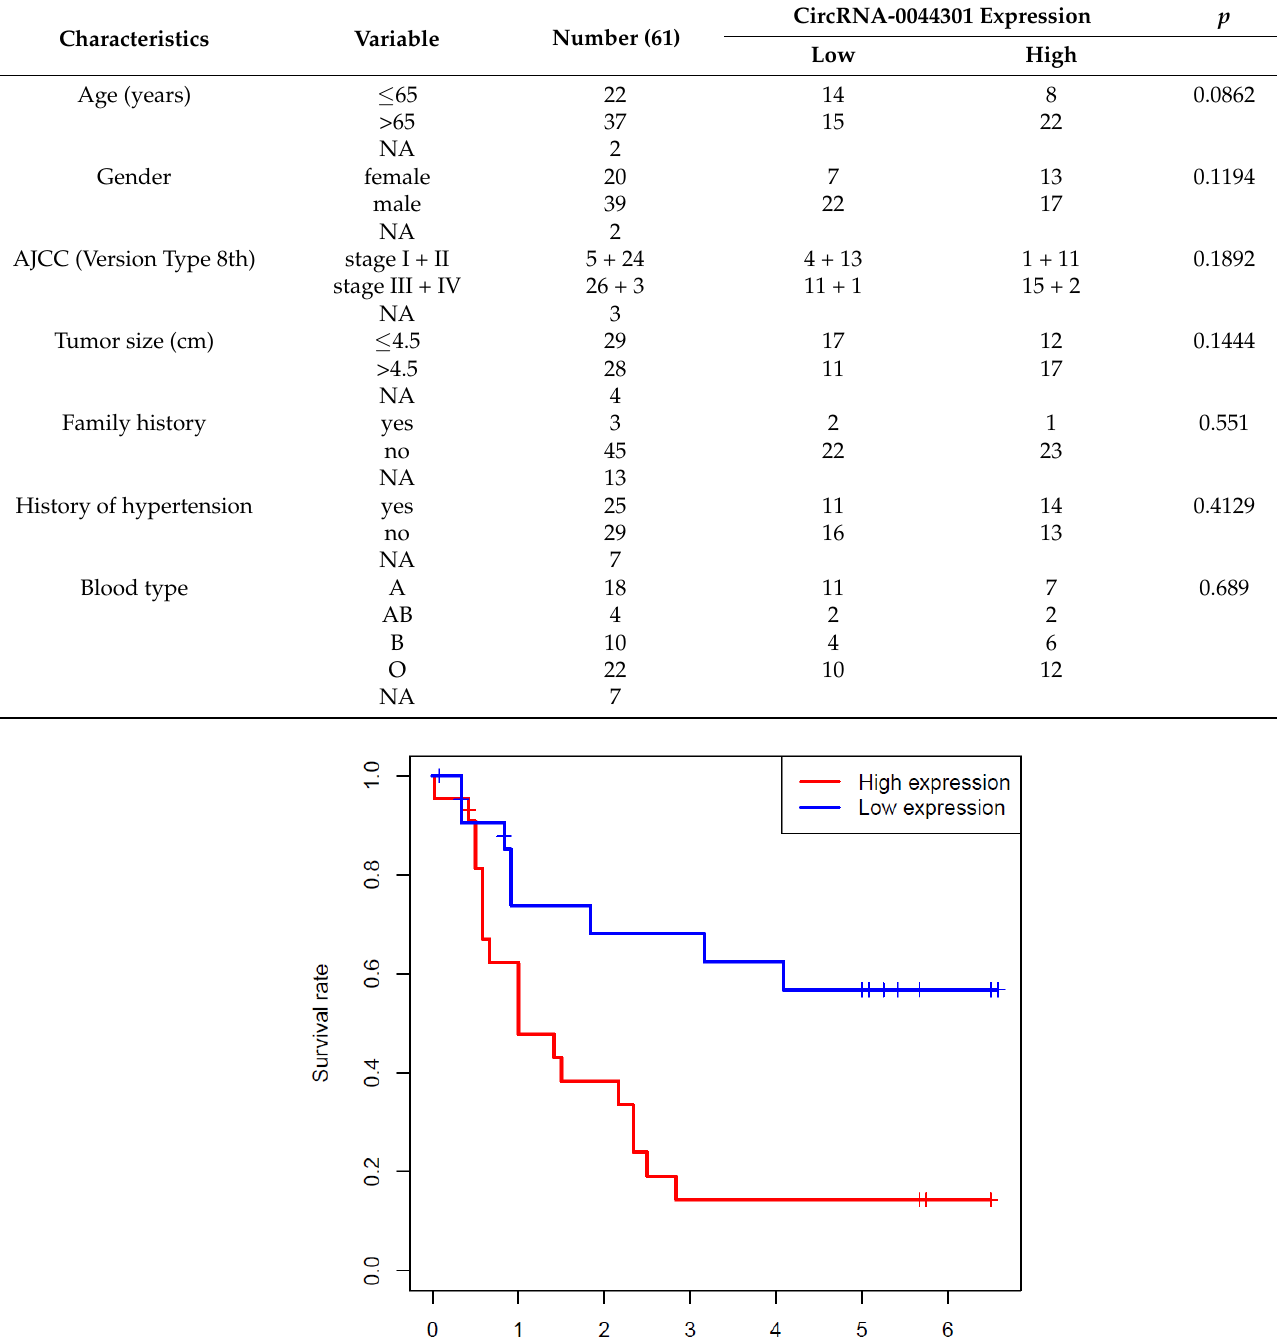
Table 1. Analysis of the correlation between circRNA-0044301 expression and clinicopathological parameters ( χ 2 Test).